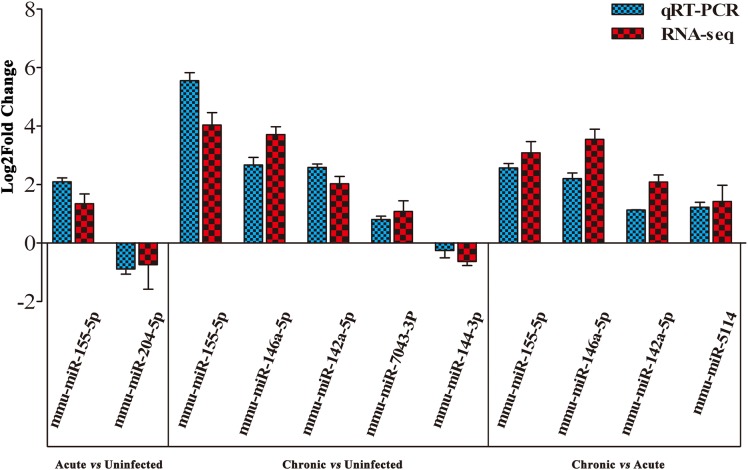
Validation of the differentially expressed miRNAs using qRT-PCR. A bar graph showing the agreement in the expression levels of a panel of seven miRNAs between qRT-PCR and the sequencing data. Columns and error bars indicate means and standard deviations of relative expression levels (n = 3), respectively. X-axis, represents the differentially expressed miRNAs (P < 0.05). The y-axis shows the relative expression levels (log2 fold change).